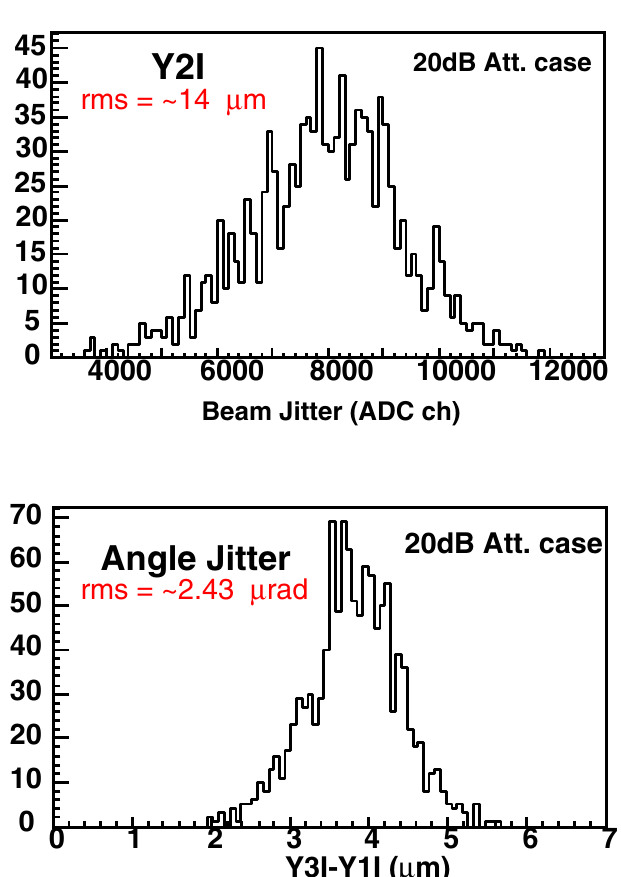
FIG. 14. (Color) Results of the calibration run. The top plot shows ADC readouts as a function of beam position for the three BPMs. Lines are the fitting results. Average and variation of the calibration results of repeated measurement are plotted in the bottom plot for various settings of the